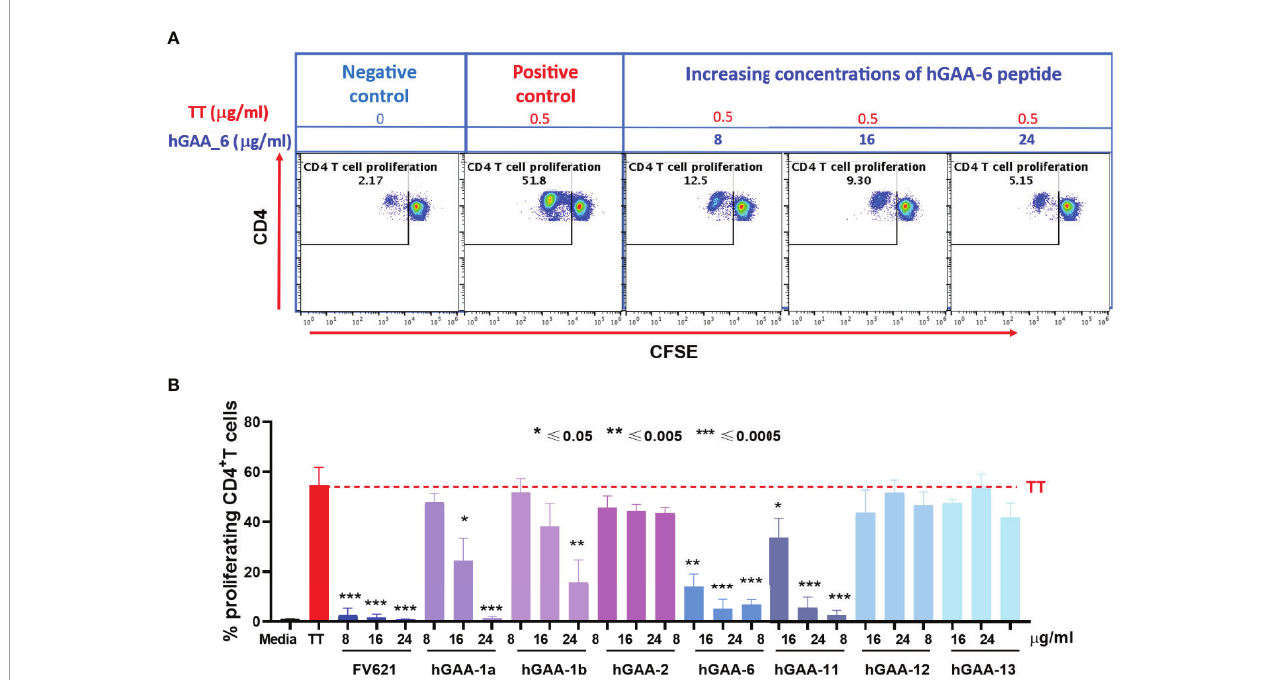
FIGURE 5 | GAA-derived peptides inhibit memory CD4 T cell response to Tetanus Toxoid (TT) in healthy donors. (A) Representative fl ow cytometry dot plots show CD4 memory T cell proliferative response to TT and dose-dependent inhibition by hGAA-6 peptide. (B) Inhibition of CD4+T cell recall response by GAA-peptides in TTBSA. PBMCs from healthy donors were stimulated with 0.5 µg/ml of TT with or without FV621 or GAA-peptides and analyzed at six days post-stimulation by fl ow cytometry for inhibition of CD4+ T cell proliferation. Data are the representative donor from 5 donors in the experiments. Signi fi cant suppressive capacity of CD4+ T cell proliferation was observed for 4 putative Treg peptides in GAA con fi rming their regulatory potential across all donors tested. P values * ≤ 0.05, ** ≤ 0.005 and *** ≤ 0.0005 represents statistical signi fi cance between peptide stimulation vs TT using a two-tailed t test. GAA peptides 1a, 1b, 6 and 11 signi fi cantly suppressed the expansion of TT-memory T cells in this in vitro